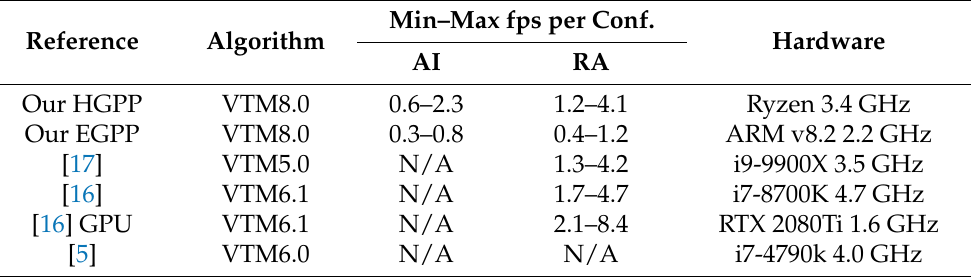
Table 8. Comparison of the number of fps decoded by different VVC